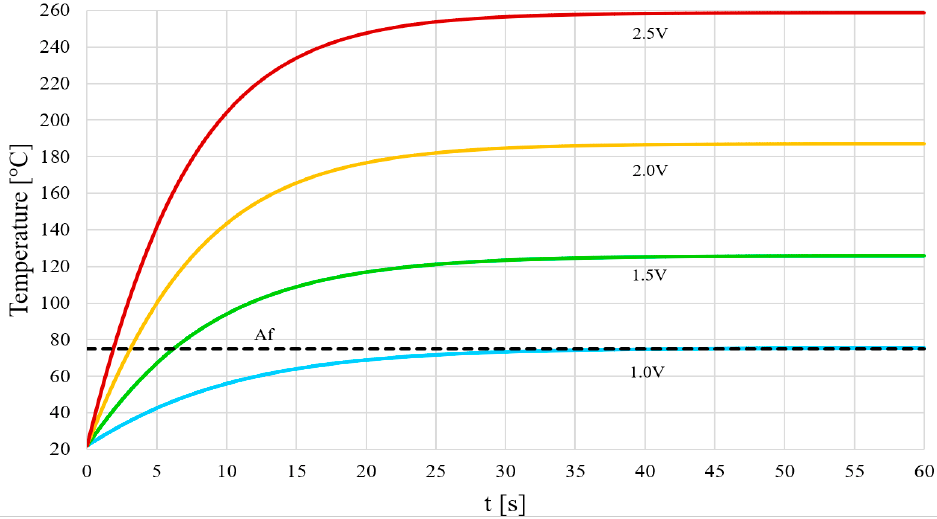
Figure 3. Temperature-Time graph for SMA element in air with different applied voltages.